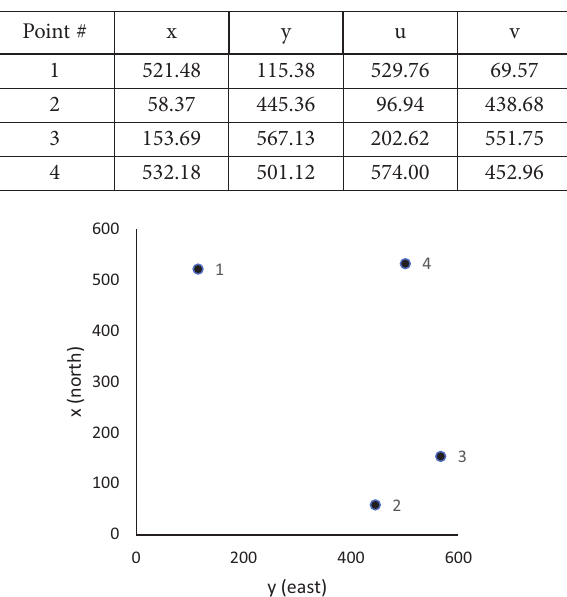
Figure 1. Location of the points in x, y coordinate